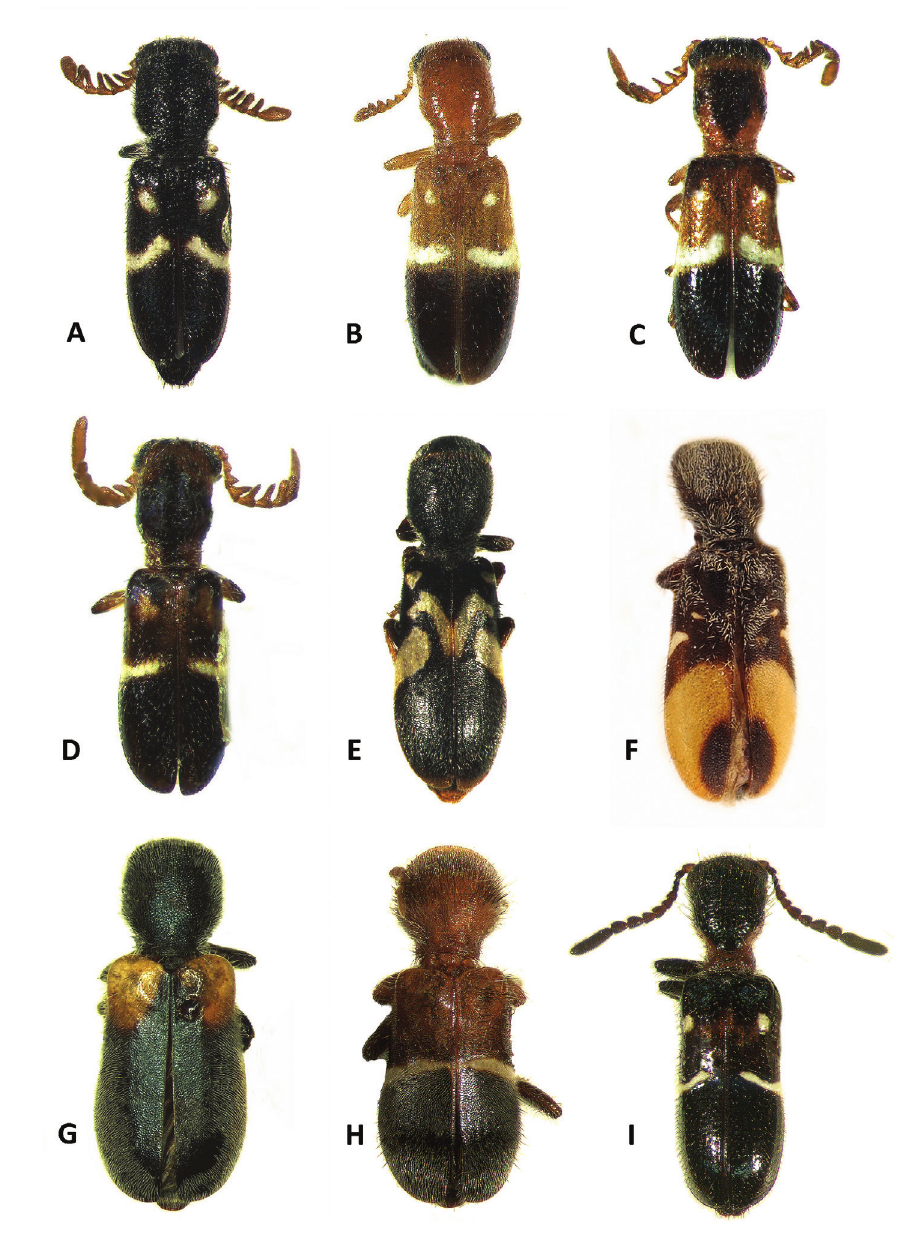
Figure 1. Habitus of: A Neocallotillus elegans ( Callotillus elegans elegans ) male B N. elegans ( C. e. vafer ) female C N. elegans ( C. e. vafer ) male D N. elegans ( C. e. elegans ) male E N. intricatus ( C. intricatus ) male F N. crusoe ( C. crusoe ) holotype male, (image courtesy of The American Museum of Natural History, New York) G Callotillus bahamensis male H C. eburneocinctus male I Barrotillus kropotkini